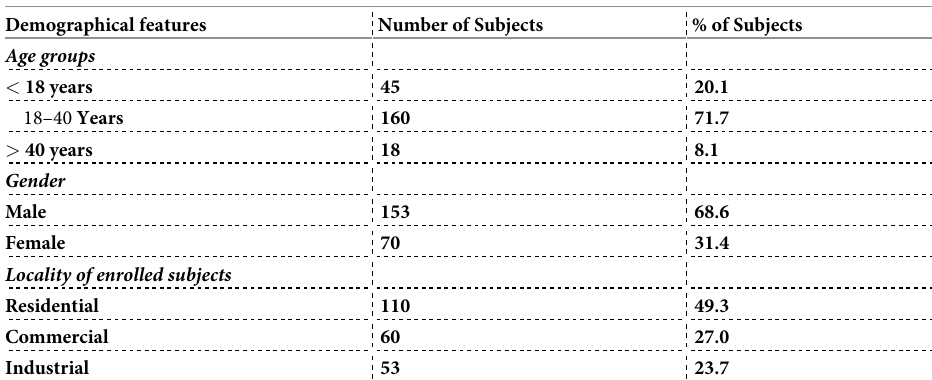
Table 1. Demographic profile of the subjects involved in the